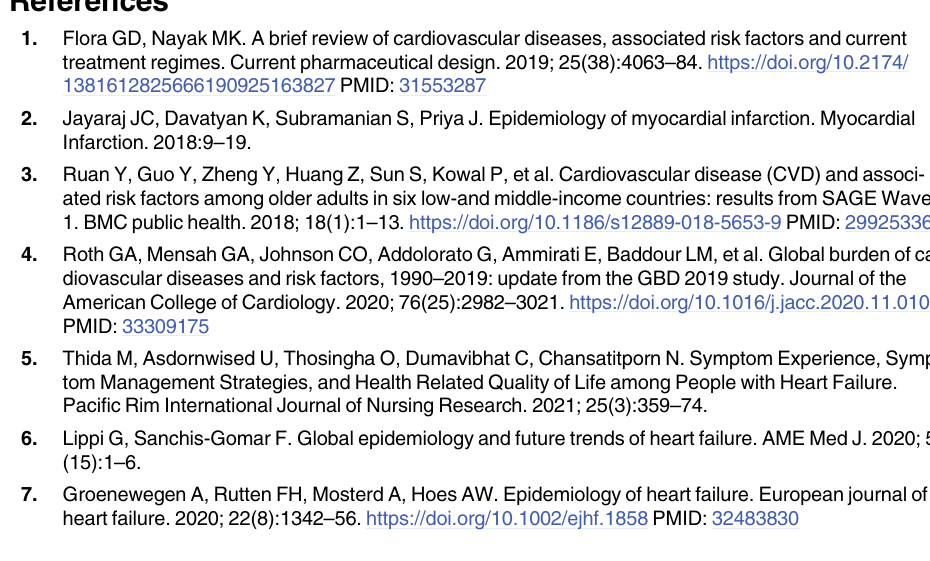
S1 Table. Search strategy of databases from January 2012 to August